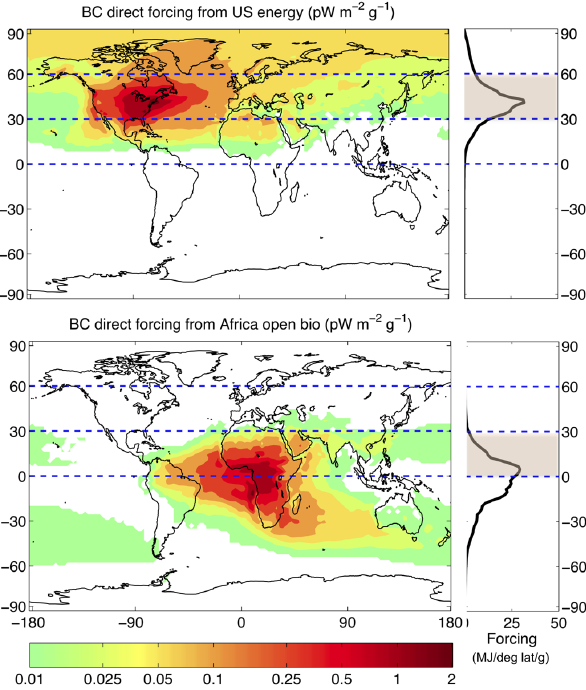
Fig. 2. Demonstration of forcing by BC emitted in a specific region, exerted upon other receptor regions. Here, the receptor regions are latitude bands. Maps to the left show total forcing from energy- related emissions in the United States (top) and open biomass burn- ing in Africa (bottom). Figures to the right show zonal integrals of forcing, normalized to emissions. SFP is the integral over lati- tudes of interest. Shading in the right graphs shows two examples: SFP BC (30 ◦ –60 ◦ N) and SFP BC (0 ◦ –30 ◦ N). USen AfrOpen